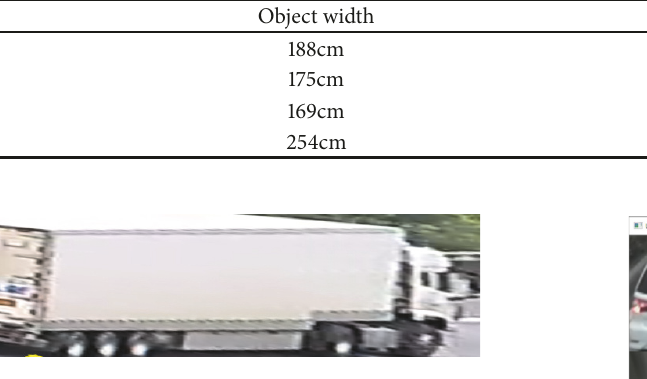
Figure 36: The inverse projection of the left view of truck.